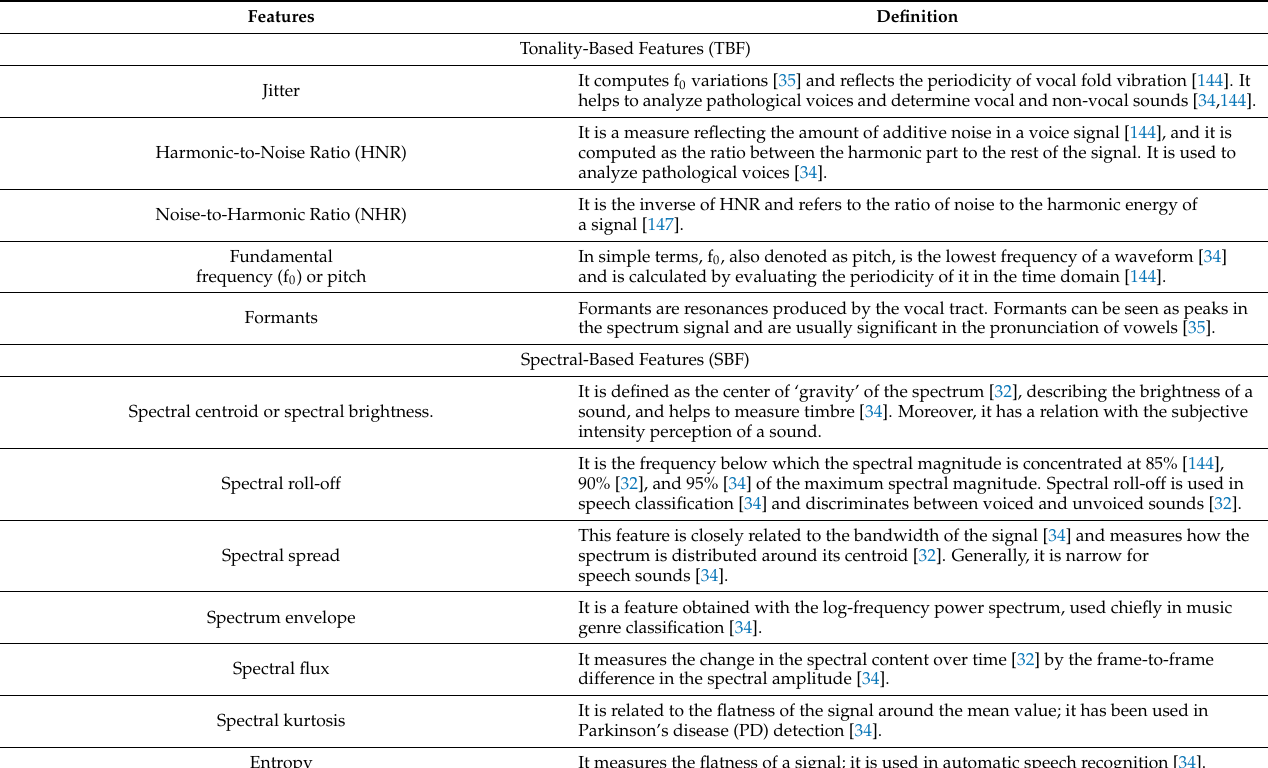
Table A2. Definitions of the frequency features present in the majority of